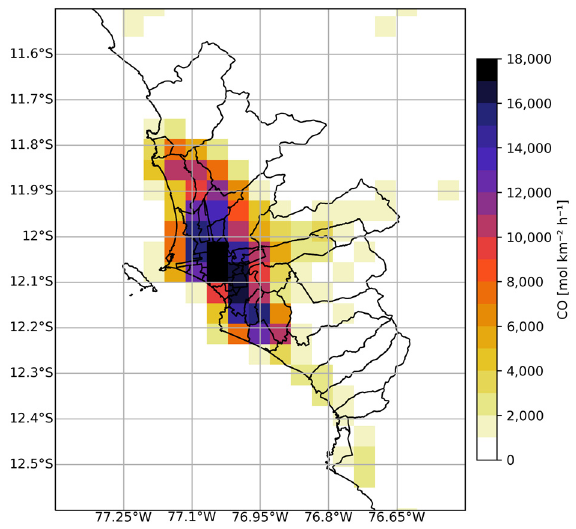
Figure 3. Spatial distributions of CO emissions (in mol km − 2 h − 1 ) at 13:00 h UTC in the Metropolitan Area of Lima and Callao (MALC).